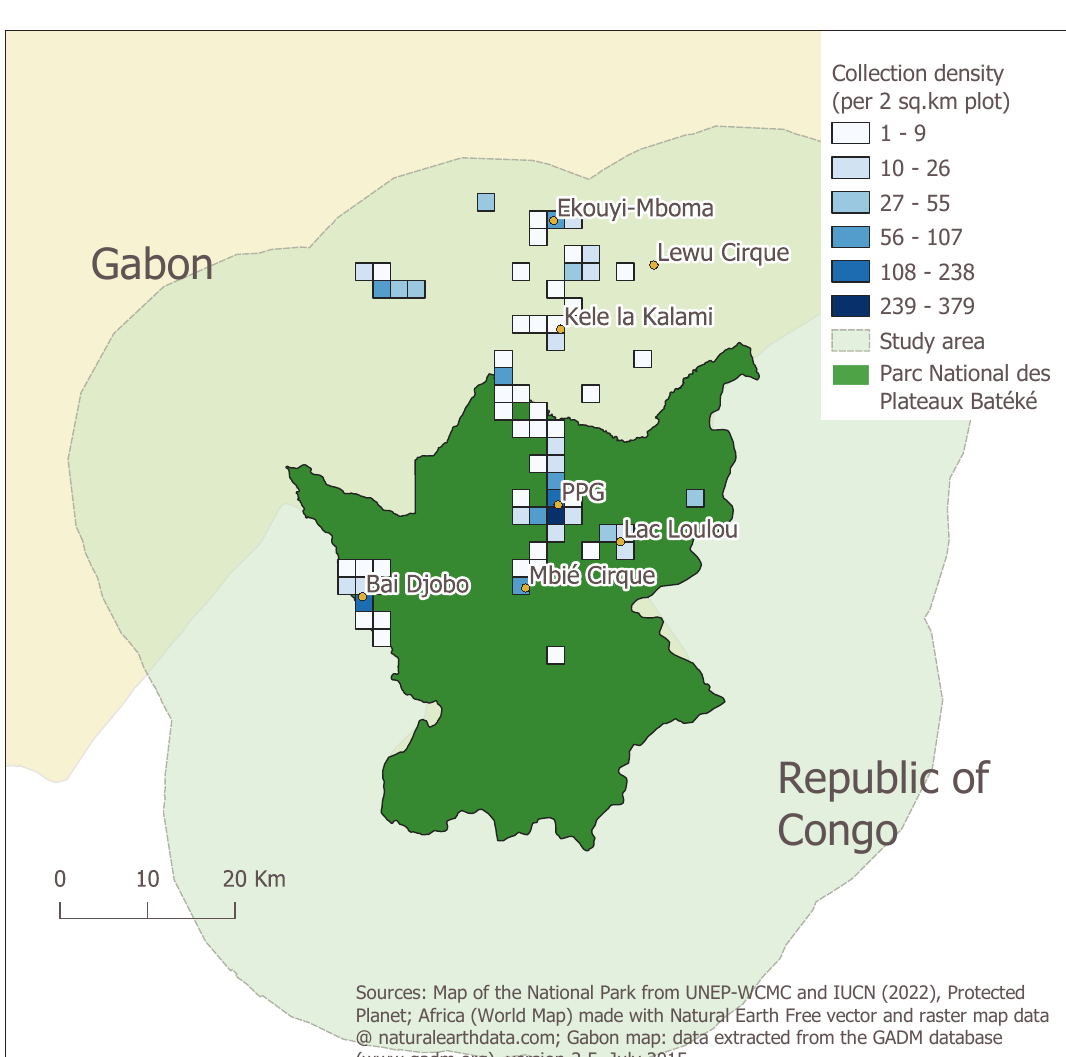
Figure 3. Collection density map of the study